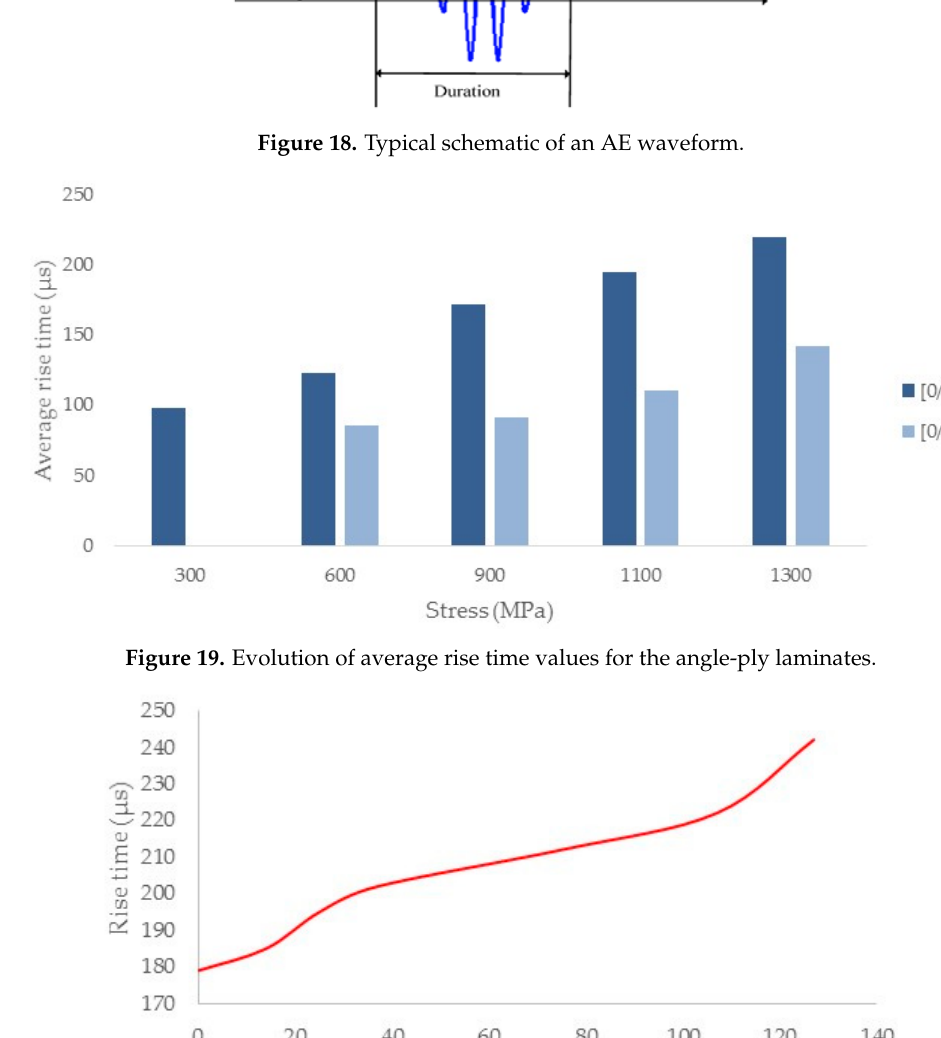
Figure 20. Evolution of average rise time versus the delamination length in the [0°/30°] 2s laminates.